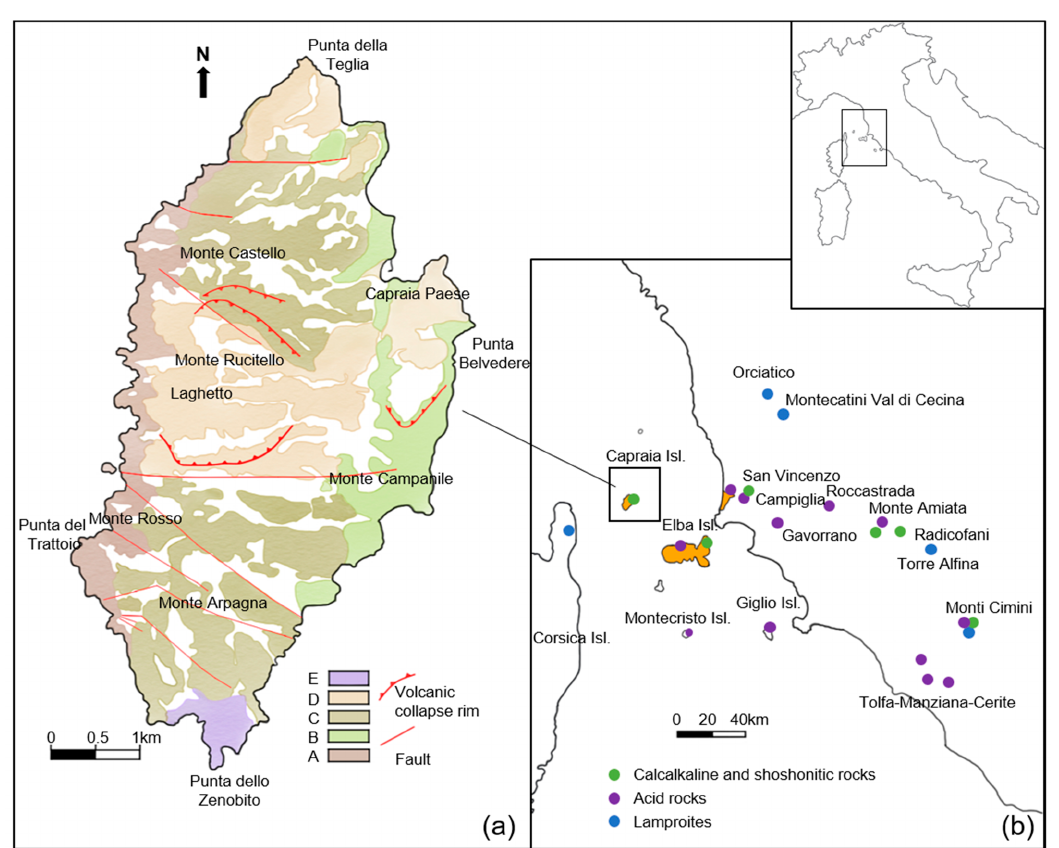
Figure 1. ( a ) Geological map of Capraia Island (modified from [4]). Legend: A = Monte Rosso Synthem, B = Monte Campanile Synthem, C = Monte Castello Synthem, D = Monte Rucitello Synthem, E = Punta dello Zenobito Synthem. ( b ) Location of the magmatic centres of Tuscany Magmatic Province (TMP). The orange areas indicate the occurrence of adakite-like rocks. Based on the available data, CA-SHO and LMP mafic end-members were likely formed by melting of anomalous mantle rocks contaminated by variable amounts of sub- ducted sediments (see [7–9] and others). The compositions falling in between CA and LMP mafic magmas might result from mixing between the two end-members. An alternative hypothesis is that the entire range of mafic magmas is primary and was generated in a mantle source containing variable proportions of veins and geochemically barren mantle rocks entering into the melt (e.g., [10]). According to Poli [11,12] and Poli and Peccerillo [3], the compositions falling between mafic and crustal anatectic rocks (i.e., the bulk of outcropping rocks) represent mixtures between crustal and mafic melts. In contrast, Farina et al. [13] suggested that the primary magmas were generated by different degrees of melting of sedimentary to igneous crustal protoliths, with variable amounts of residual phases being incorporated in the melts. A distinct group of intermediate to acidic calcalkaline rocks showing high Sr, Ba and LREE has been distinguished by Poli and Peccerillo [3] among the Orano dykes at Elba Island, for mafic enclaves in the San Vincenzo rhyolites, and at Capraia Island. It was sug- gested that this represents a distinct type of magma, which had not been recognised by previous studies. Actually, the high-Sr-LREE of these rocks had been already pointed out (e.g., [14–16]), but petrogenetic significance and regional distribution were not explored.